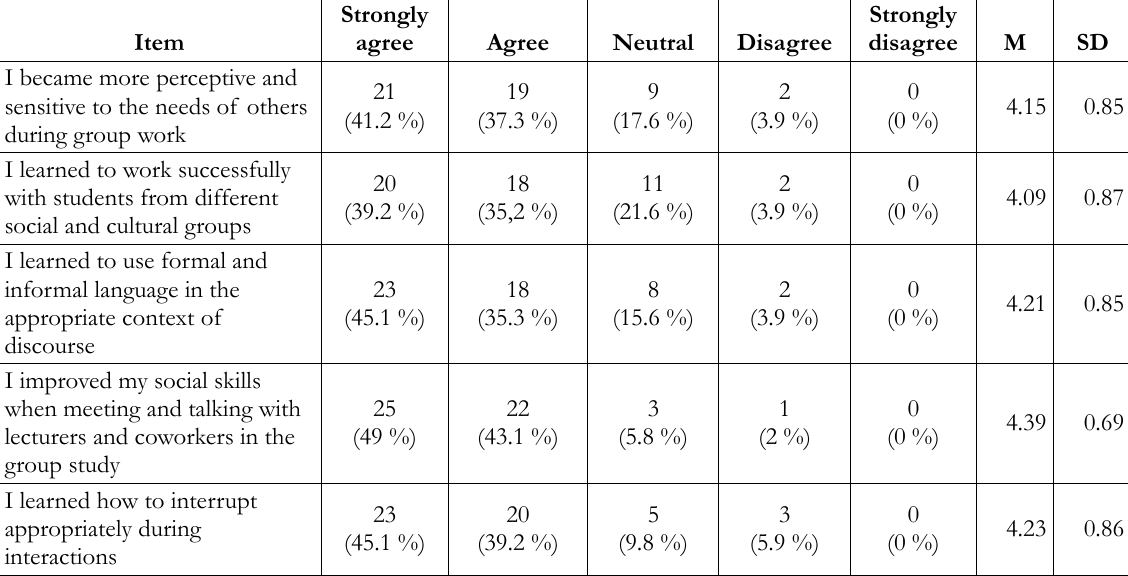
Table 7. The data analysis of students’ perceptions of interpersonal skills